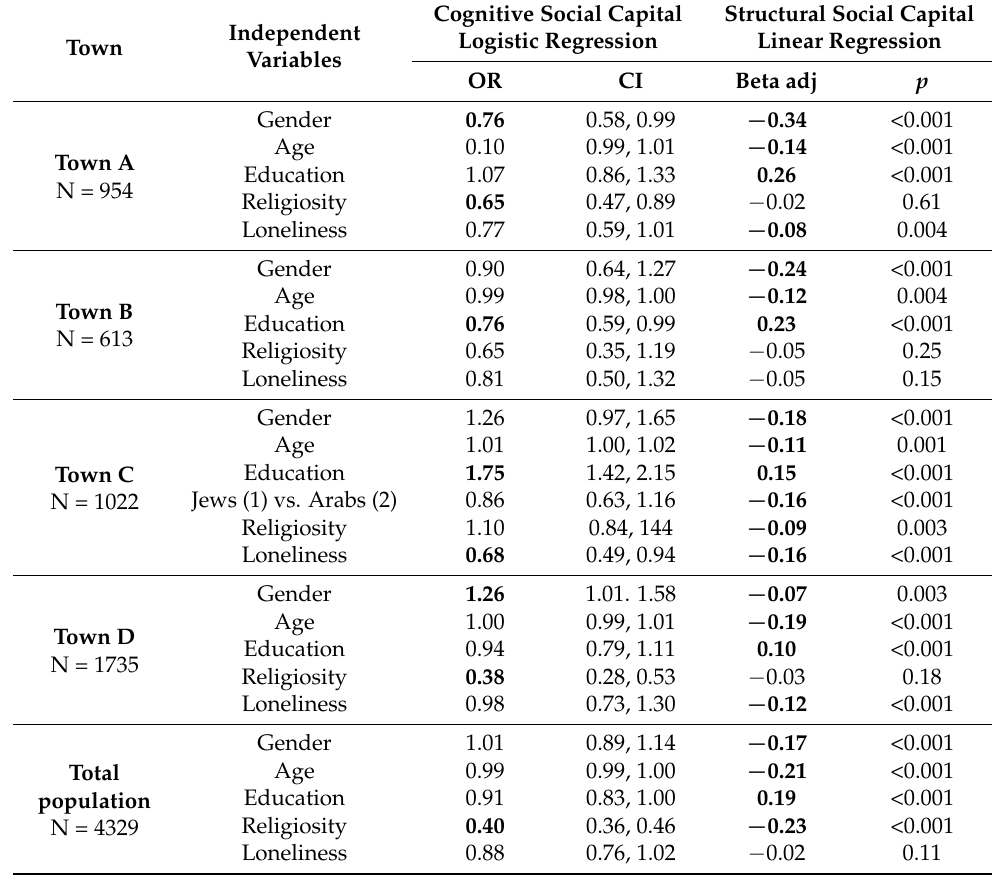
Table 3. Variables associated with social capital, logistic regressions presenting odds ratio (OR) and confidence intervals (CI), and linear regression. Independent Town